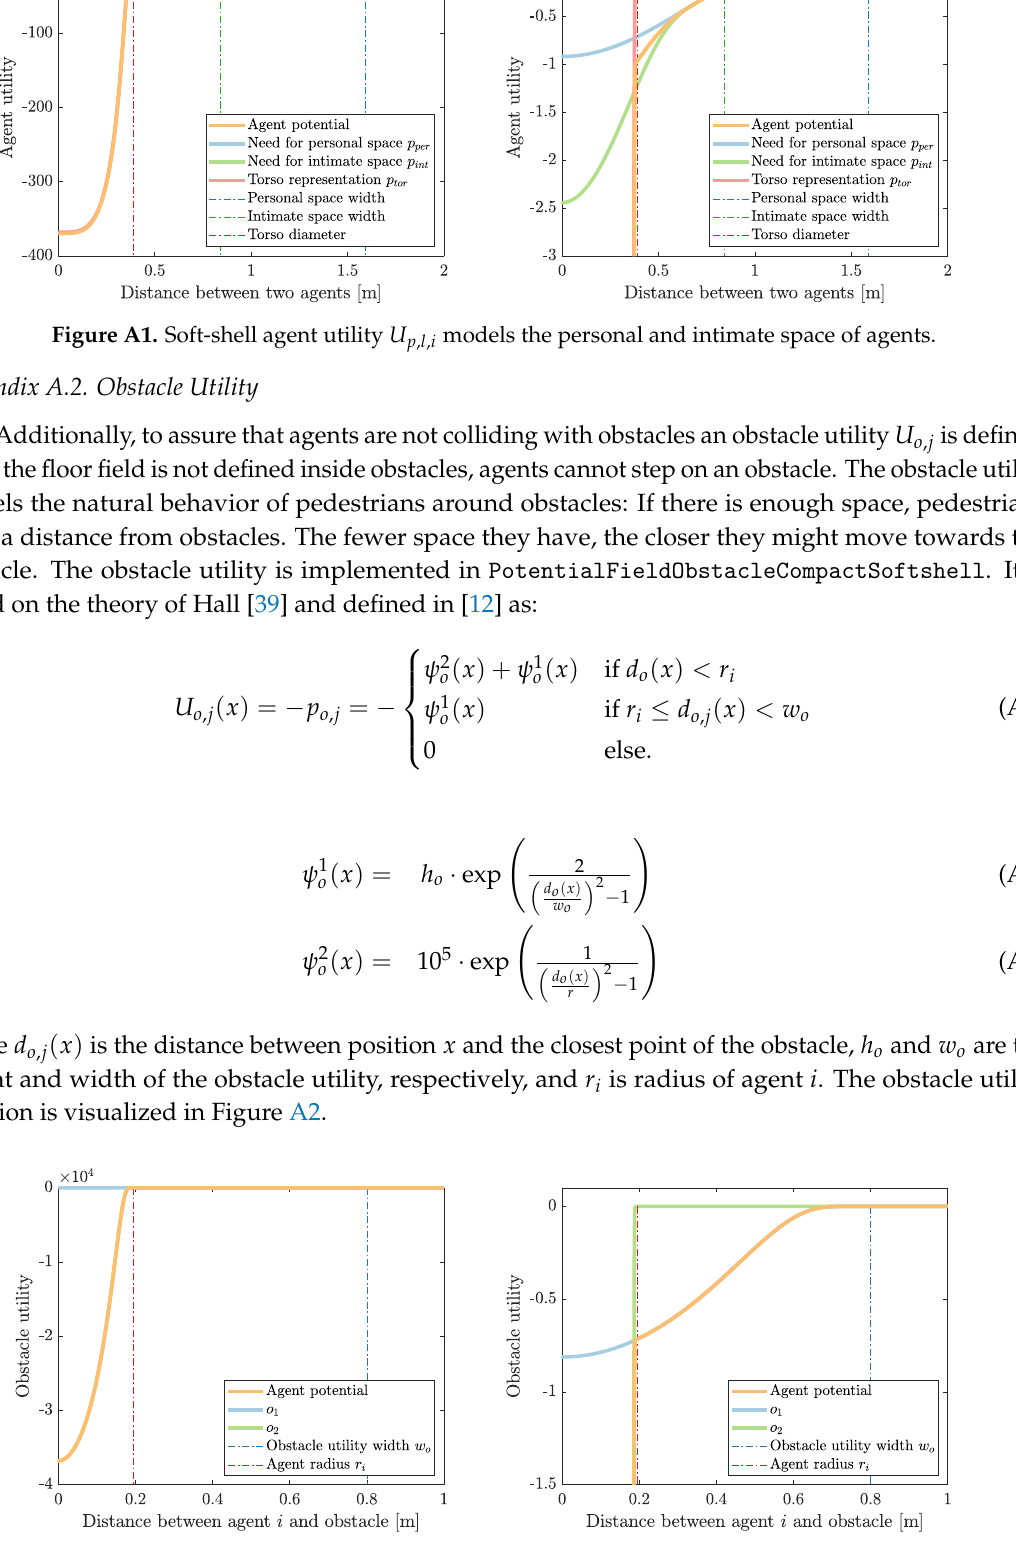
Figure A2. Soft-shell obstacle utility U o , j models the behavior of an agent around an